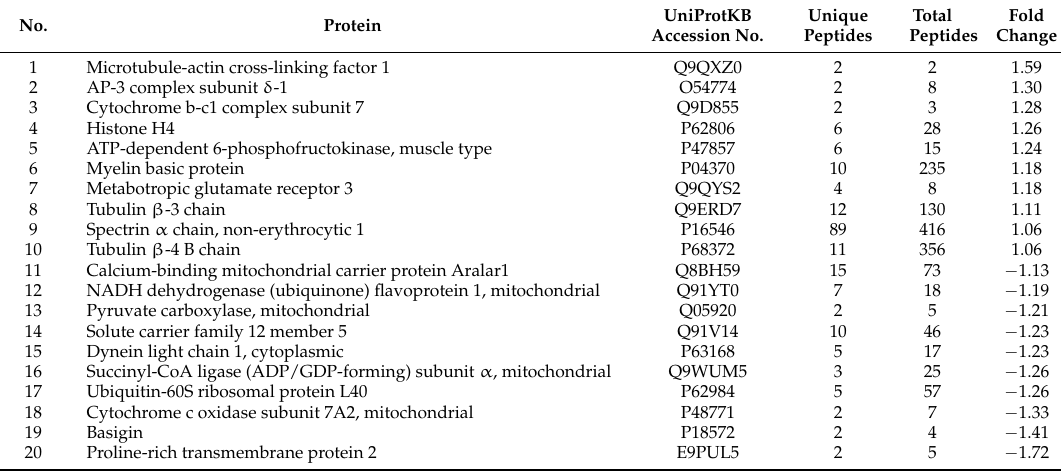
Table 3. Differentially expressed proteins in the frontal cortex mitochondria of apoE − / − group vs. wild type animals ( p < 0.05, n =